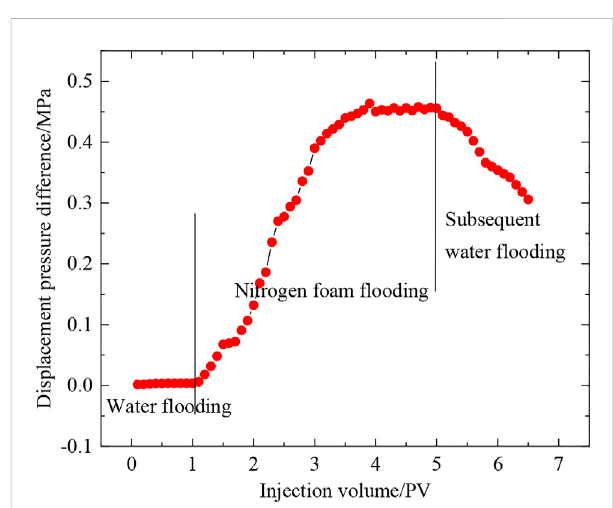
FIGURE 3 Pressure differences between water fl ooding and foam fl ooding under oil-free